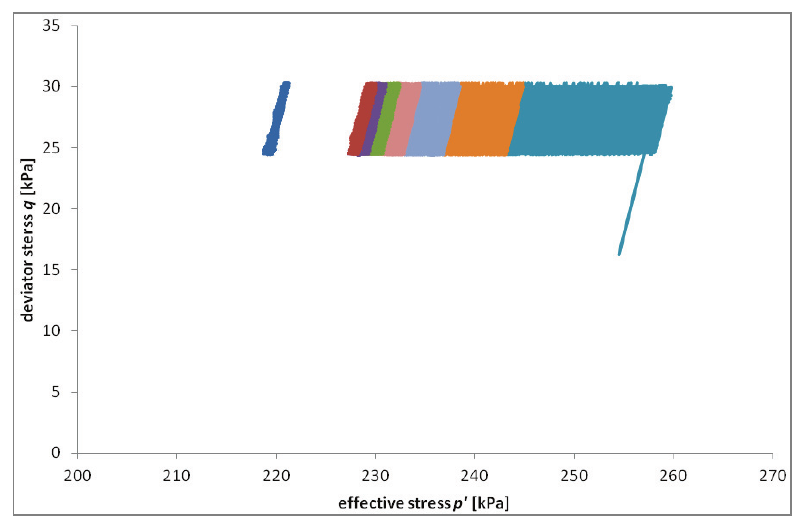
Fig. 1. Plot of effective stress and deviator stress from repeated loading triaxial test for sandy-silty